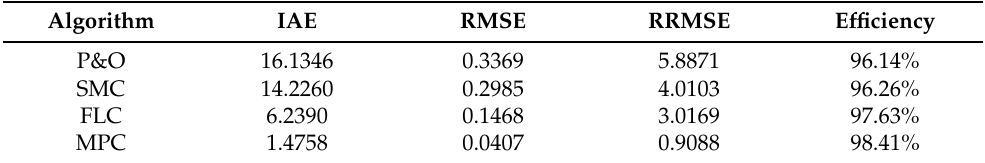
Table 5. Comparison of the different